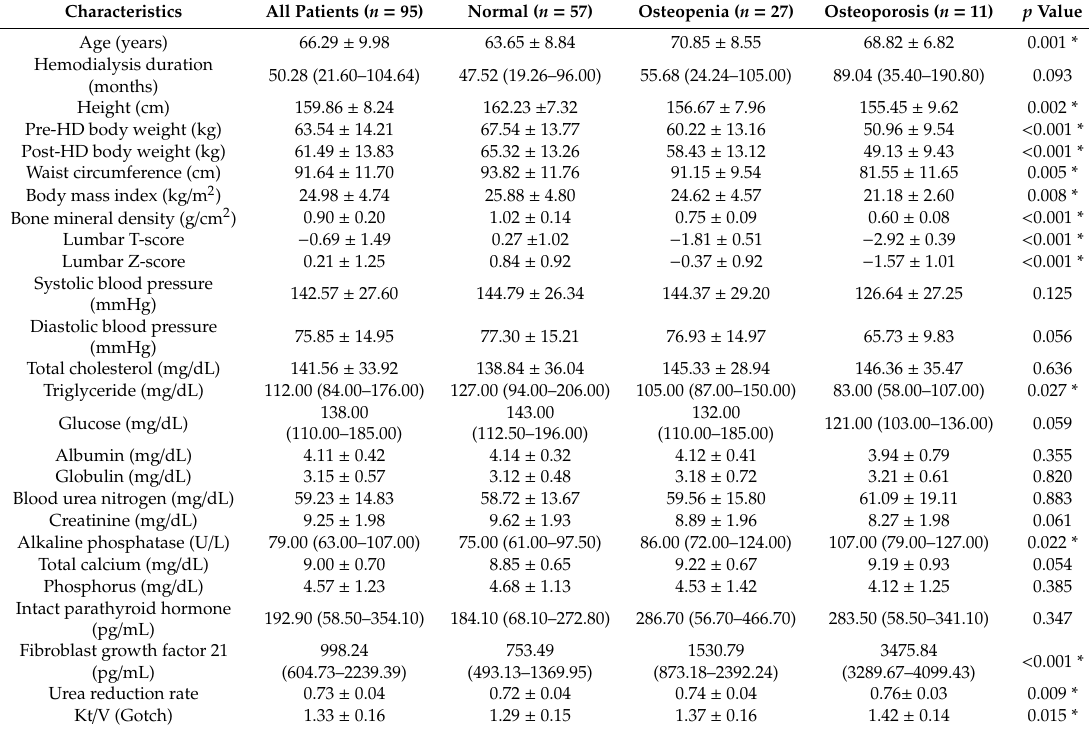
Table 1. Baseline characteristics by categories of bone density in our study.